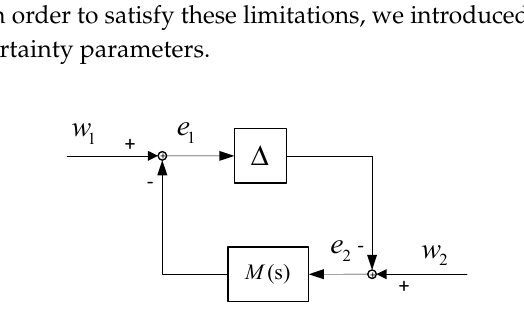
Figure 4. Standard M − Δ configuration of a system with perturbations.